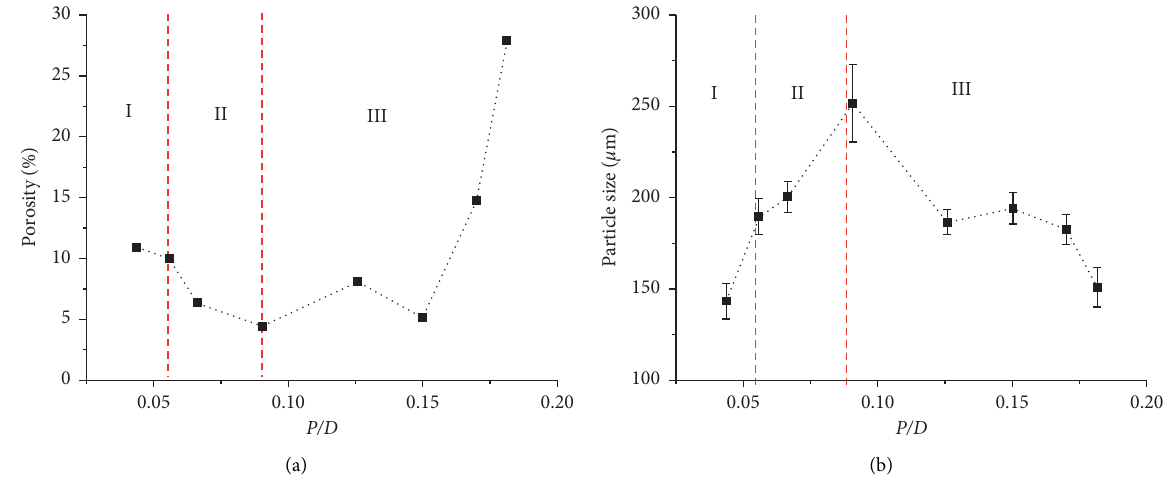
Figure 5: Variations of the (a) porosity of cutting groove of rock blocks and (b) particle size of slaking mudstone.